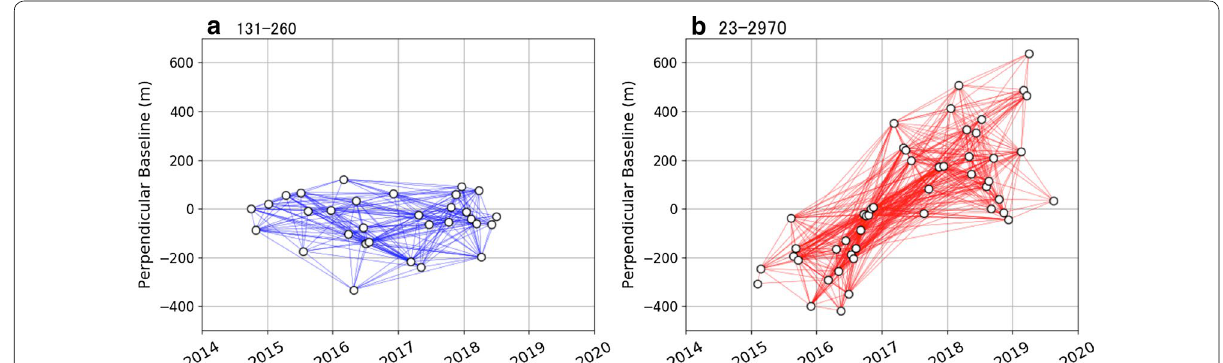
Fig. 2 Relationship between the temporal and spatial baseline of a path 131 and b path 23. White circles indicate time epochs of data acquisition